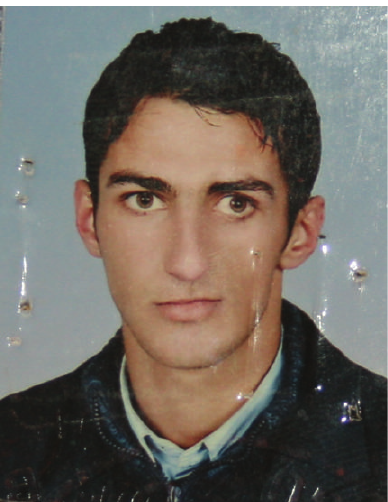
Figure 5: The patient at 16 years of age, 1 year after the first autologous fat injection.